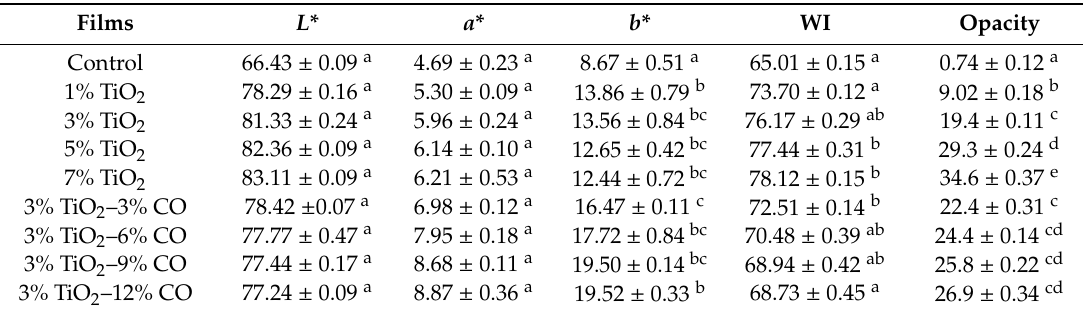
Table 3. Colour di ff erence and opacity.